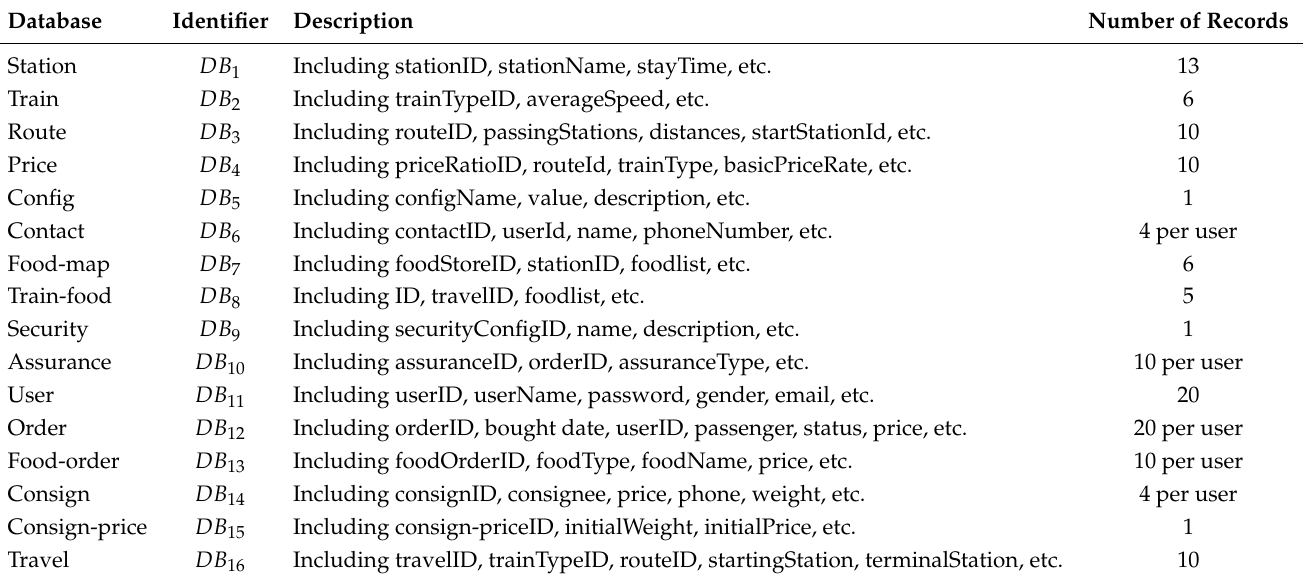
Table 7. Descriptions and settings of databases in TrainTicket